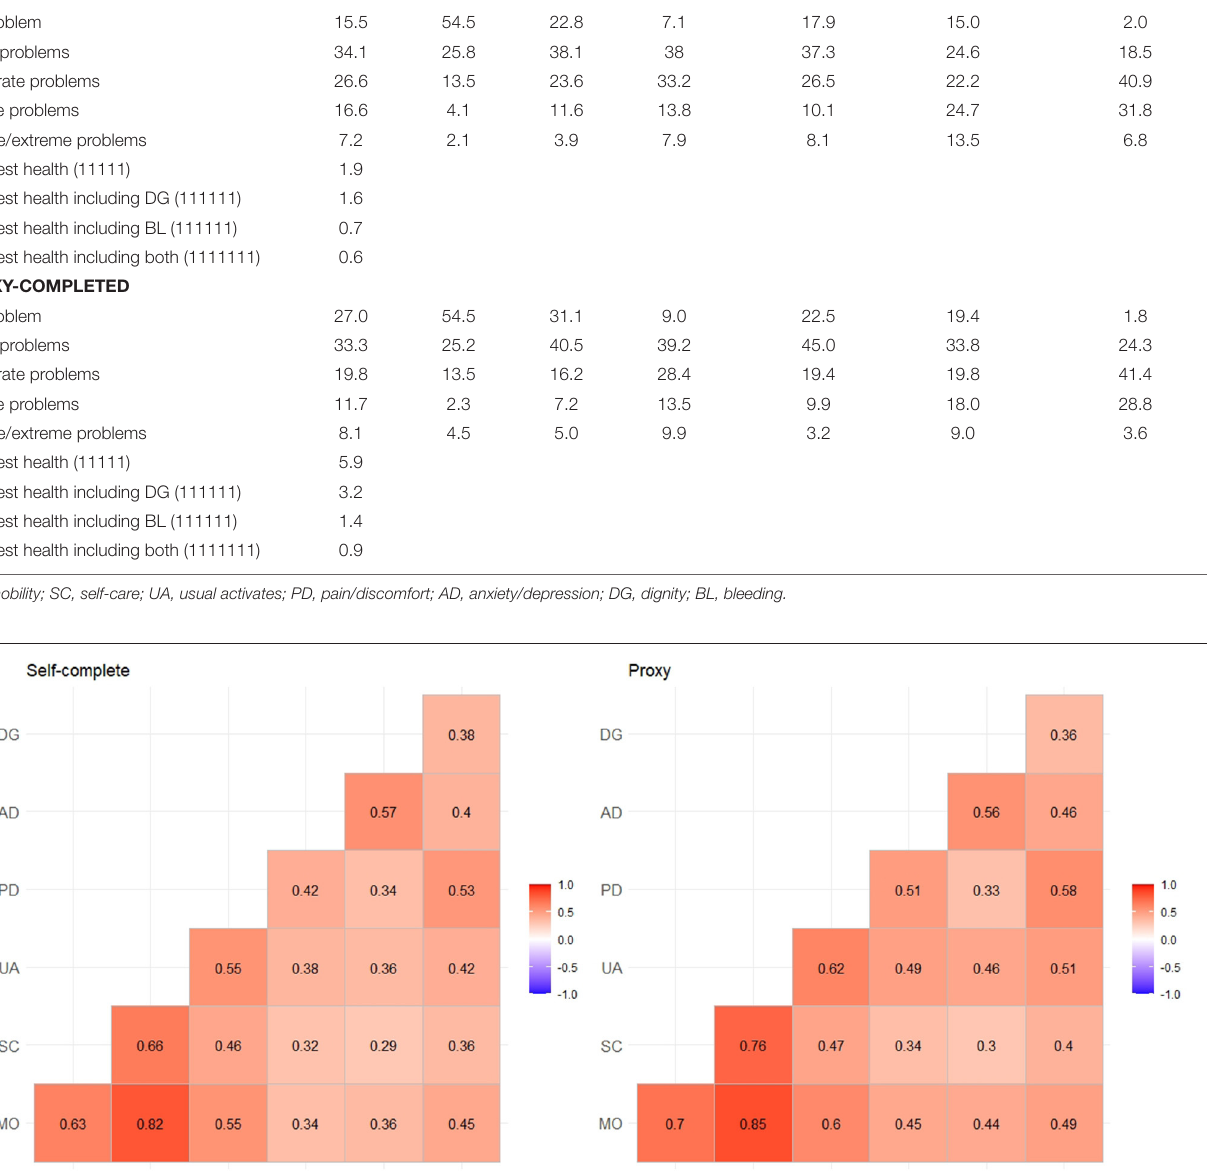
confirmed in both the self- and proxy-completed samples. We found that, compared with the EQ-5D-5L, adding two items significantly decreased the ceiling effects (68.4 and 84.7% for